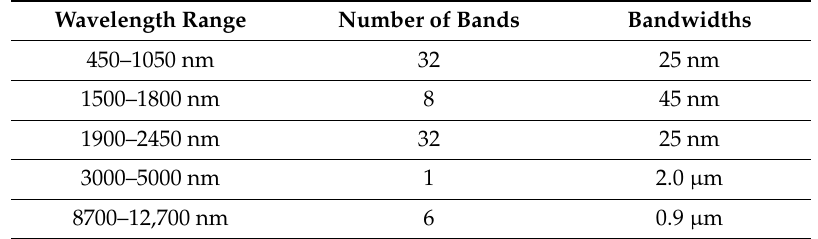
Table 2. DAIS sensor spectral range